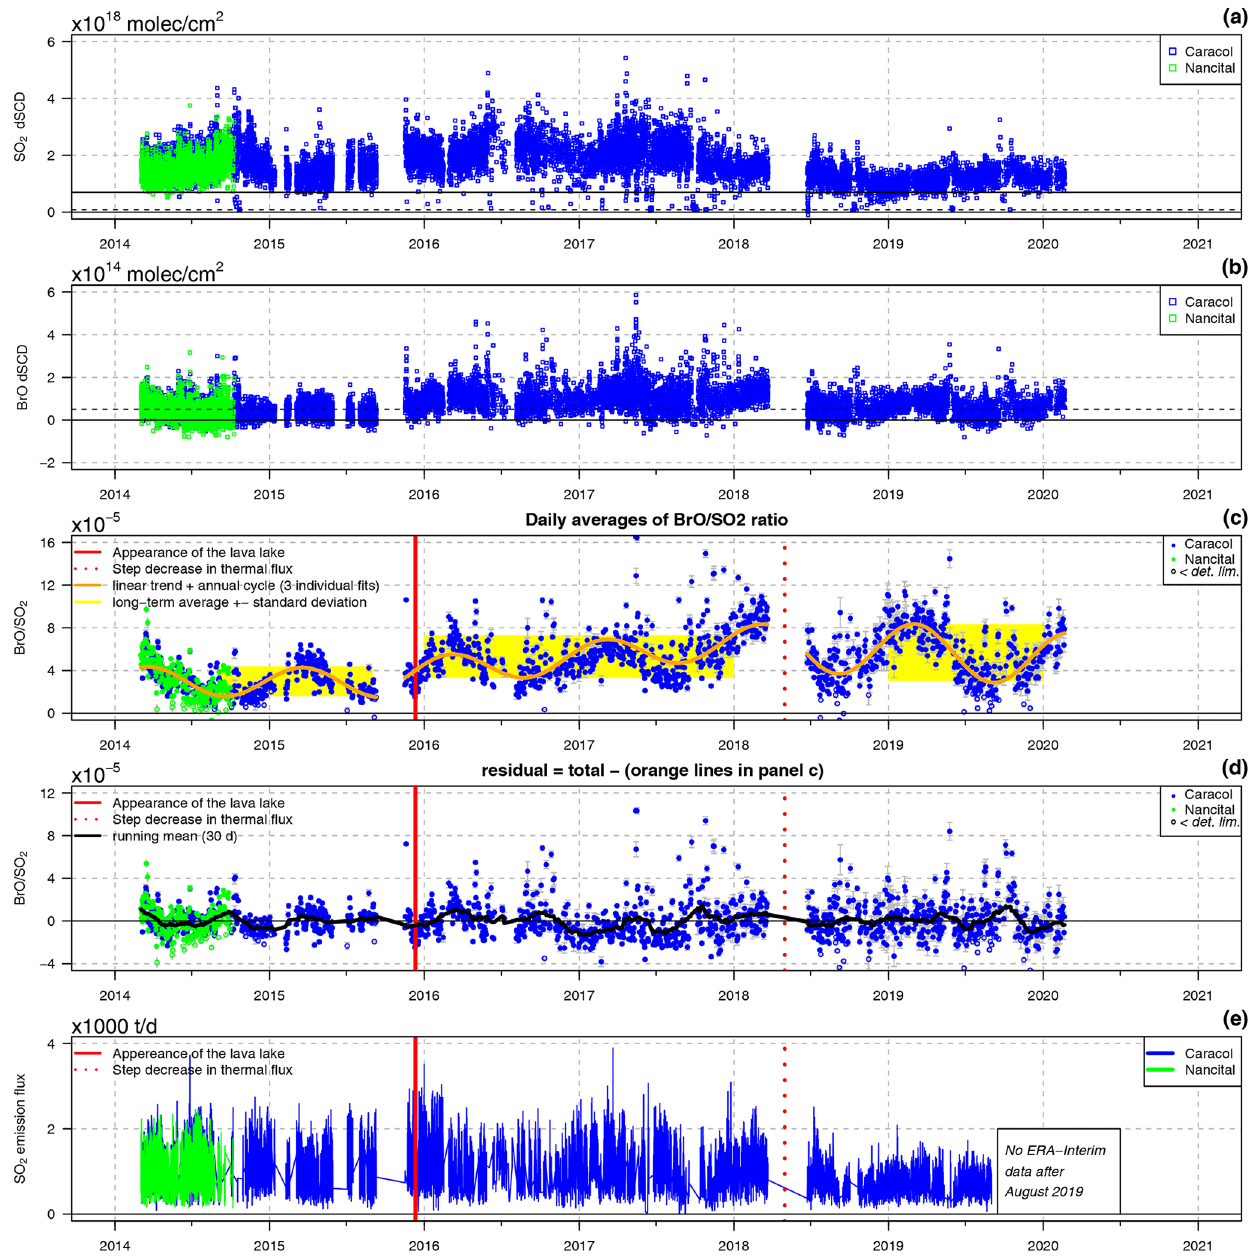
Figure 8. (a–c) Time series of the differential slant column densities of SO 2 and BrO and calculated daily means of the BrO / SO 2 molar ratios in the gas plume emitted from Masaya (long/short tick marks indicate 1 January/July). The two NOVAC stations are indicated by the different colours. (c) Best fits of the long-term pattern are given for three individual time intervals (orange lines). The yellow bands indicate the long-term averages and the standard deviations. (d) Residual BrO / SO 2 time series when subtracting the best fits from the three individual parts of the BrO / SO 2 time series. e) Daily means of the SO 2 emission